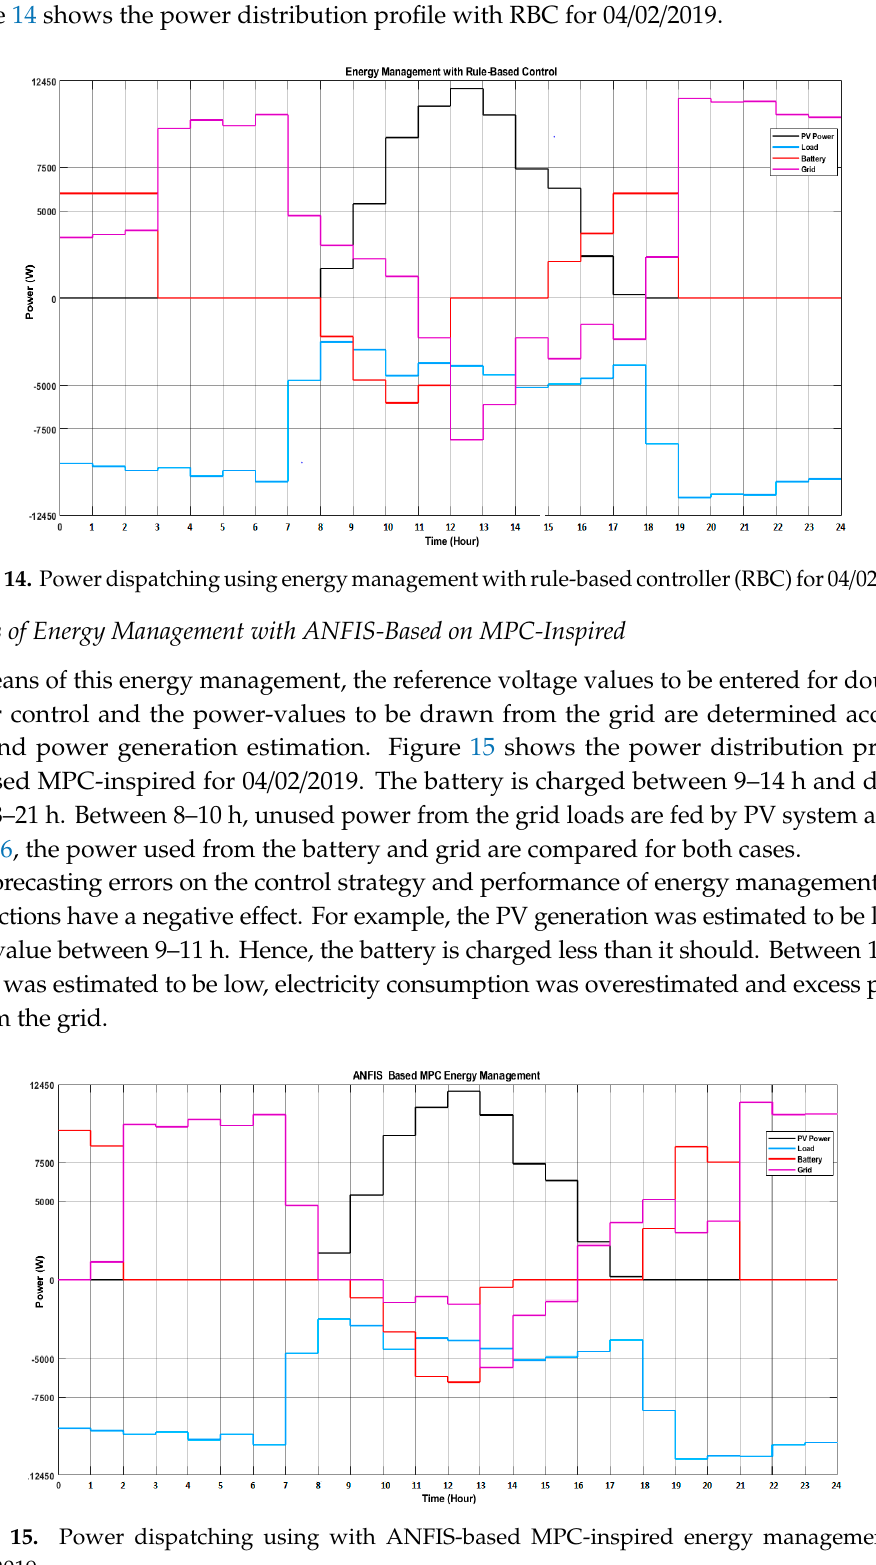
Figure 15. Power dispatching using with ANFIS-based MPC-inspired energy management for 04 / 02 /